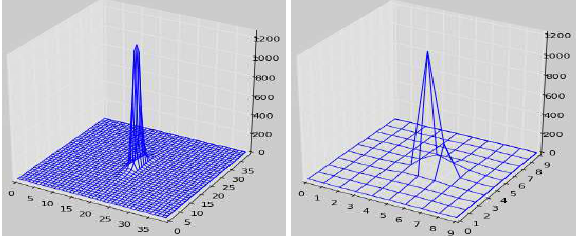
Figure 9 : XS image with a slow down factor 4 (left), and one of the four extracted images (right)